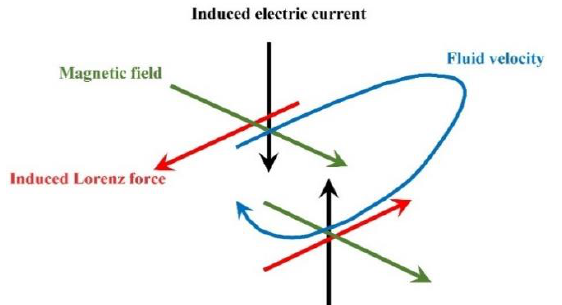
Metals 2023 , 13 , x FOR PEER REVIEW Figure 6. Coupling mechanism of steady-state magnetic field and molten pool. Figure 6. Coupling mechanism of steady-state magnetic field and molten pool.